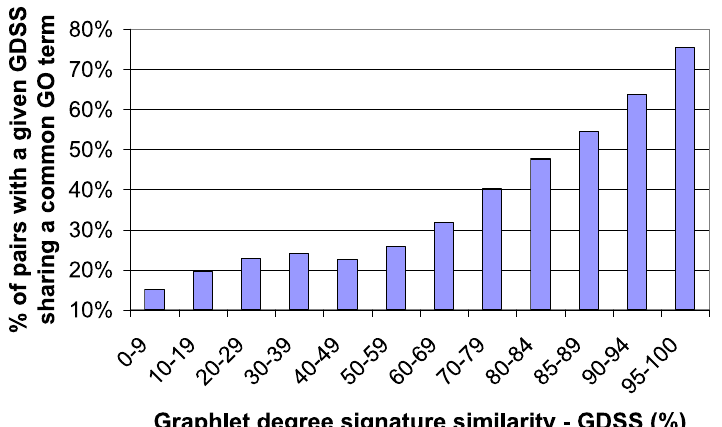
Figure 1: The relationship between topological graphlet degree signature similarities (GDSS) and the level of biological similarities of orthologous protein pairs in the baker’s yeast PPI network. For each signature similarity interval illustrated on x-axis (0%-9%, 10%-19%, ..., 90%-94%, and 95%-100%), we show the percentage of protein pairs having signature similarities within the interval that share a common